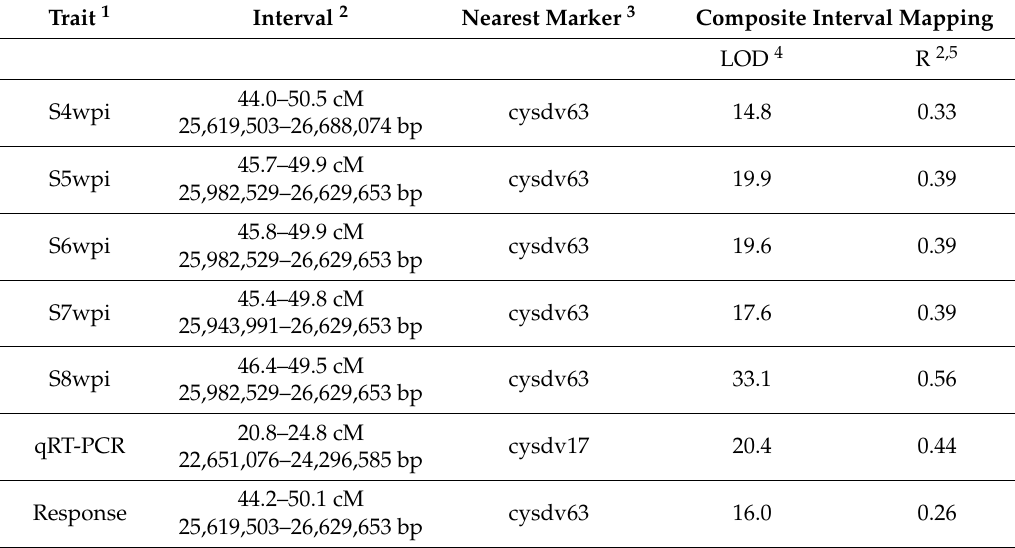
Table 3. Quantitative trait loci (QTLs) identified in chromosome 5 in BC 1 S 1 progenies of RIL 556 derived from the cross between TGR-1551 and the cultivar ‘Bola de Oro’, phenotyped for resistance to Cucurbit yellow stunting disorder virus and genotyped with marker sets CYSDV1 and CYSDV2 (see text for